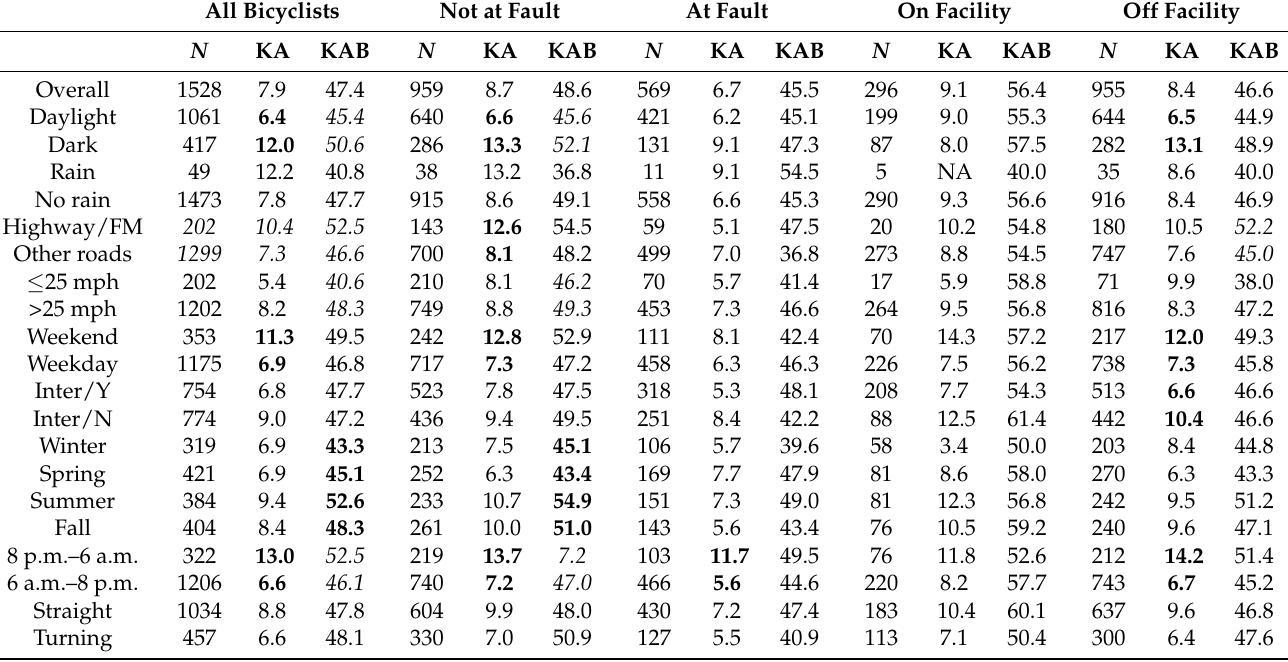
Table 3. Proportions of bicyclist KA and KAB crashes in San Antonio from 2014–2018 corresponding to bicyclist-related variables.